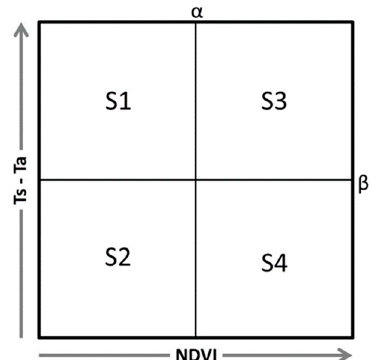
Figure 4. Characterisation of pixels based on NDVI threshold ( α ) and Ts - Ta threshold ( β ). S4 denotes irrigated crop / pasture; S3 denotes possible crop or pasture which is not currently irrigated; S2 denotes wet conditions with no or negligible vegetation; and S1 denotes dry conditions with no or negligible vegetation.